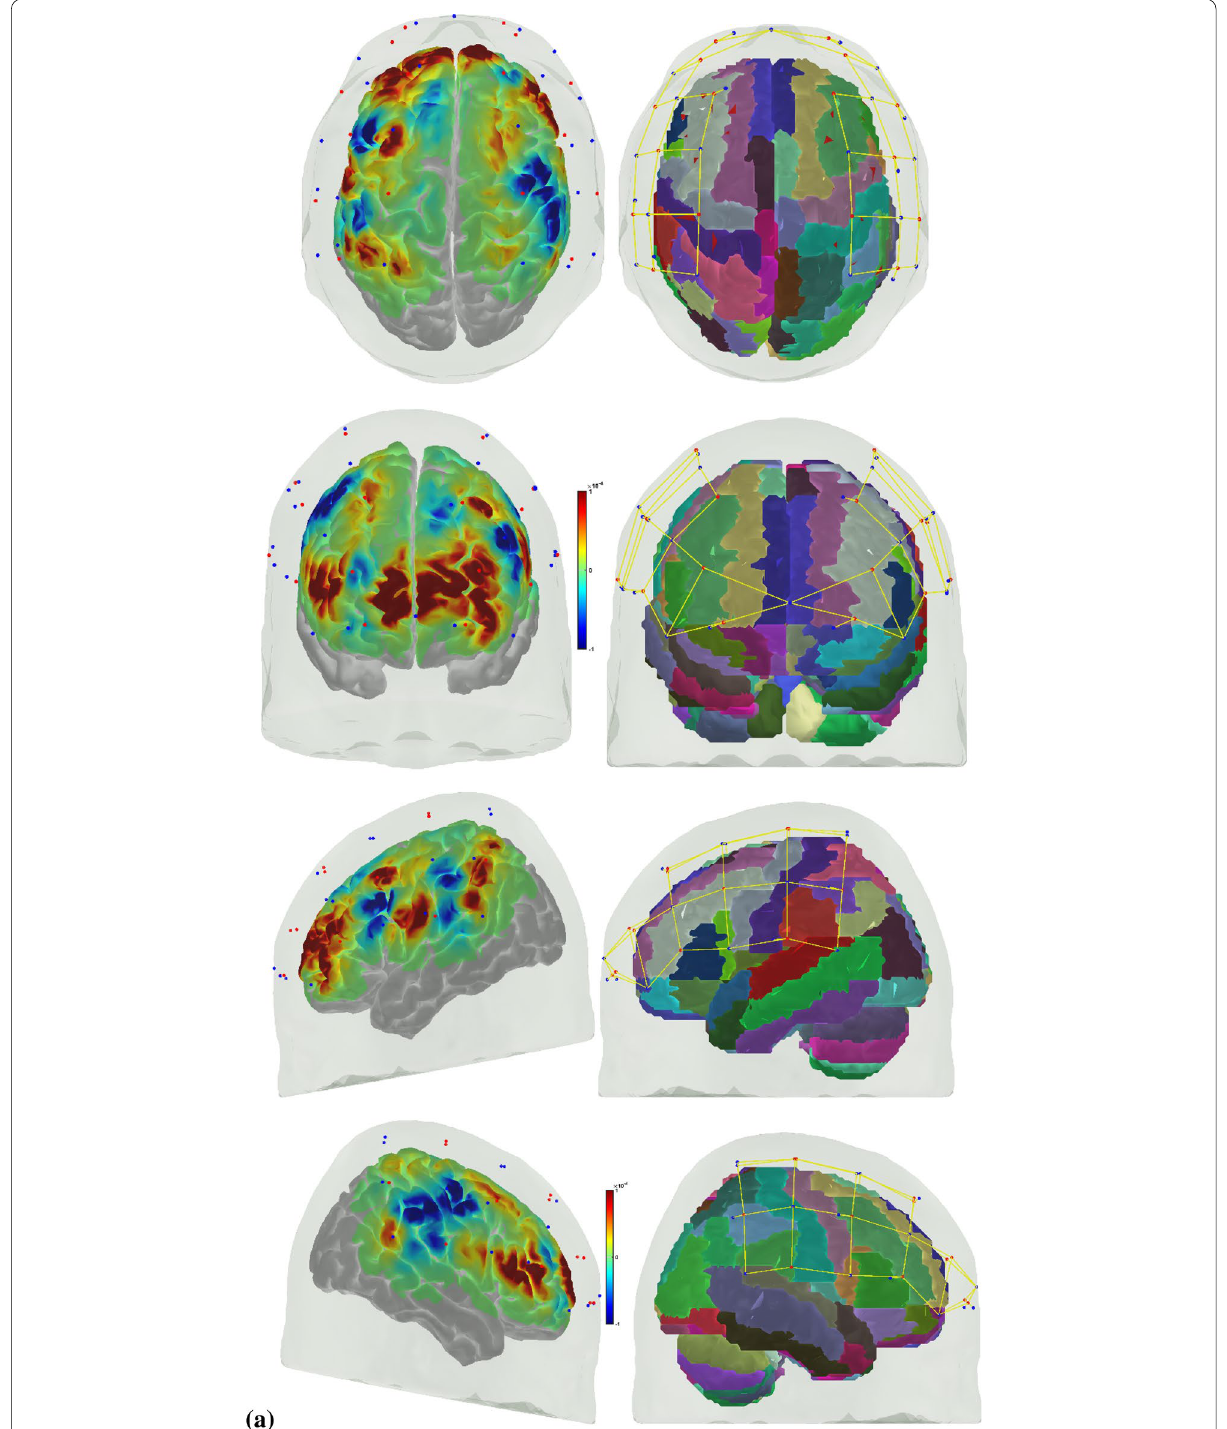
Fig. 6 Image of the changes in HbO absorption coefficient in the cortex at the group level (left panel) along with the Automated Anatomical Labelling (AAL) of the brain regions in color (right panels). A During 0 to 10 s at the start of the FLS complex task of the novices, ( B ) during 0 to 10 s at the start of the FLS complex task of the experts, ( C ) during 0 to 10 s during the error epoch of the novices, ( D ) during 0 to 10 s during the error epoch of the